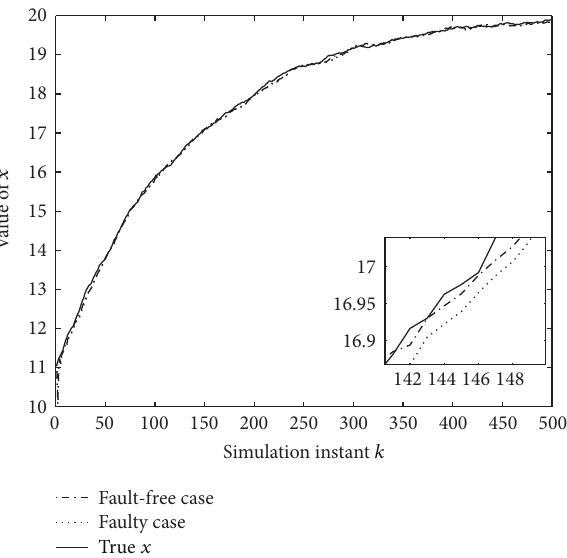
Figure 3: Detection of fault.